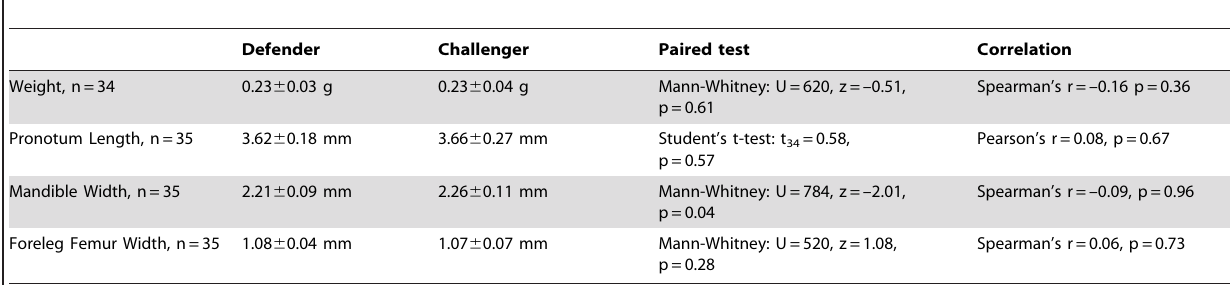
Table 2. The differences and correlations between variables for defender and challenger males from field observations (average 6